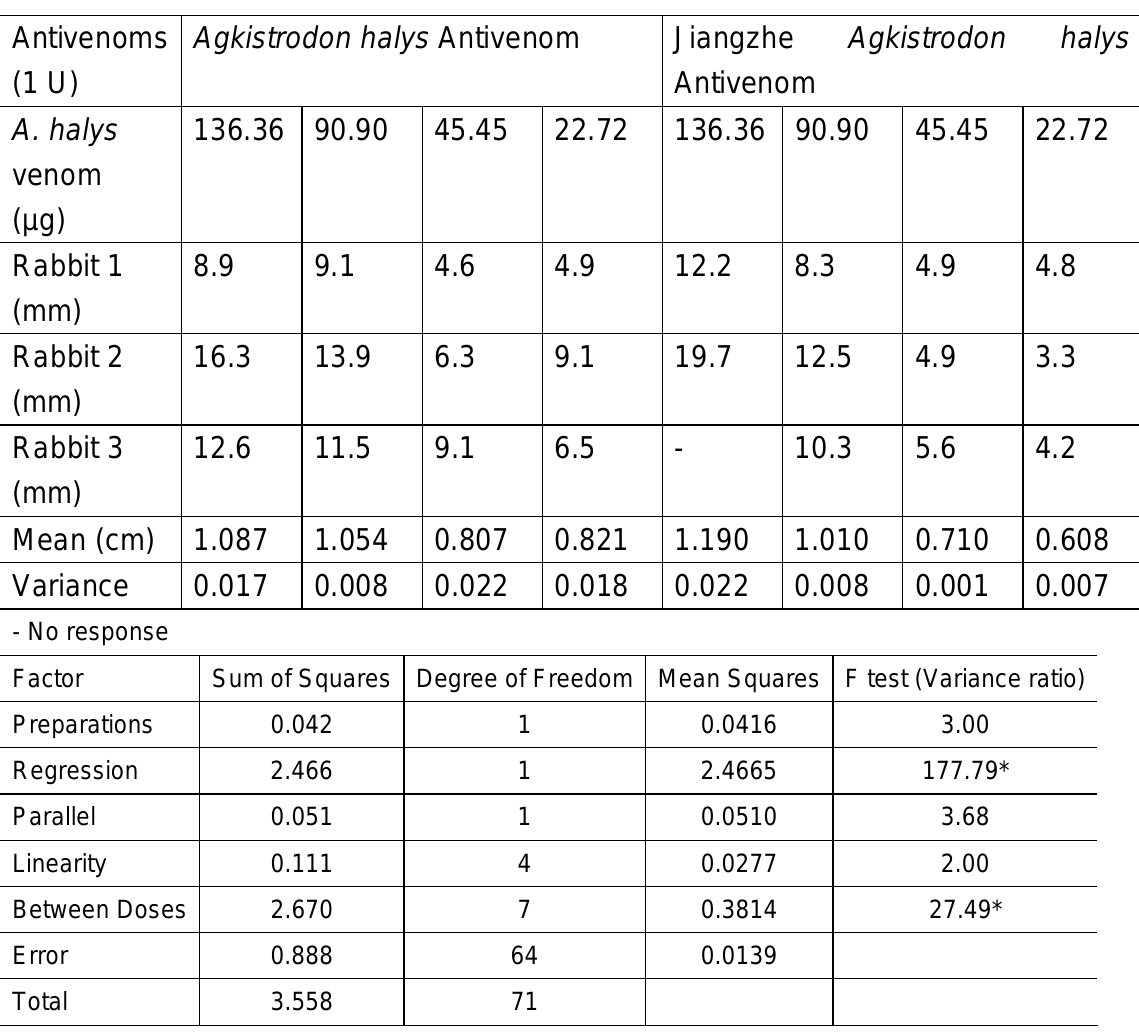
Table 3: Measurements of the neutralization of Agkistrodon halys venom by one unit of antihemorrhagic activity (1U) of Agkistrodon halys and Jiangzhe Agkistrodon halys